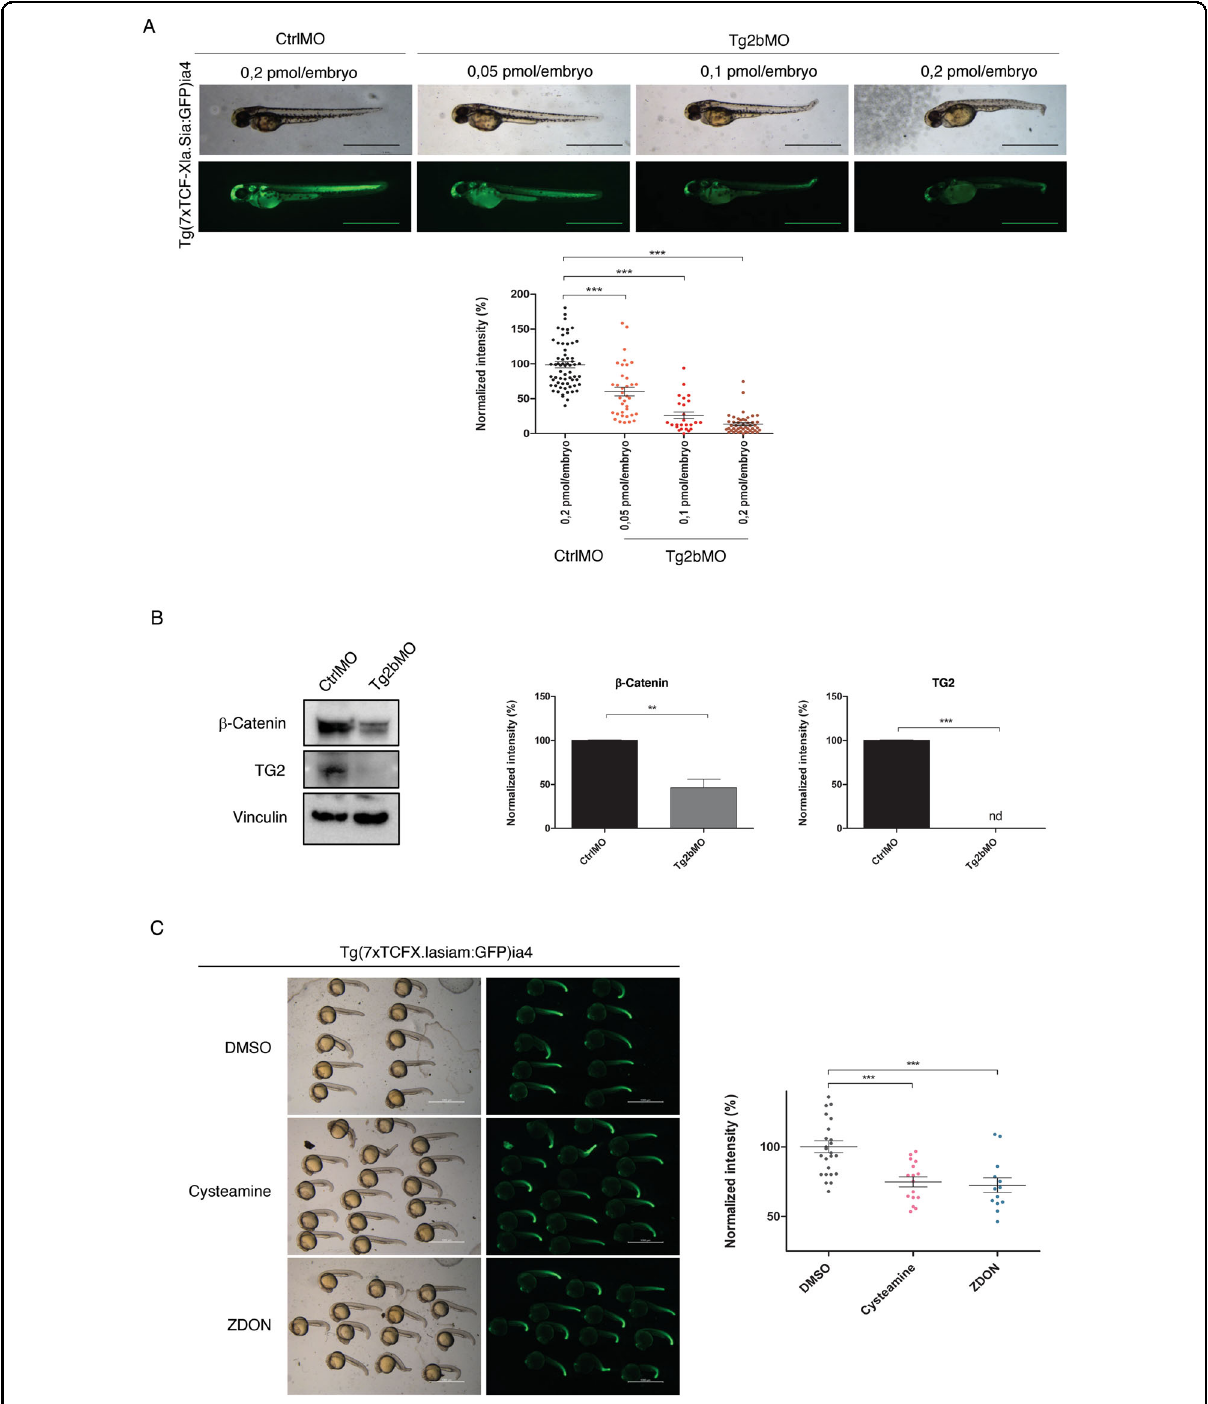
Fig. 4 TG2 modulation of Wnt pathway in the zTg2b zebra fi sh model. A Knockdown of the zTg2b was performed in Tg(7xTCFX.lasiam:GFP)ia4 Wnt-dependent reporter fi shes by injecting three increasing dosages of morpholinos (0.05, 0.1, and 0.2 pmol). Zebra fi sh at 48hpf were observed by bight fi eld and epi fl uorescence microscopy. The images are representative for the groups of animals and the GFP quanti fi cation is reported in the graph ( n = 50; means±SEM; *** p < 0.001). Bars: 1 mm. B Zebra fi sh TG2 protein and zebra fi sh β -catenin protein from KD and control larvae ’ s protein extracts were compared by western blot. The quanti fi cation is reported in the graph below. The values are indicated as the percentage of the control samples set as 100% ( n = 3; means±SEM; ** p < 0.01; *** p > 0.001). C GFP fl uorescent zebra fi sh Tg(7xTCFX.lasiam:EGFP)ia4 Wnt-dependent reporter fi shes were treated for 15 h with the following compounds: DMSO 0.2%, 40 μ M ZDON, 1 mM Cysteamine. Epi fl uorescence microscopy images are reported, whereas fl uorescence quanti fi cation is shown in the graph ( n = 50; means±SEM; *** p < 0.001). Bars: 1.5